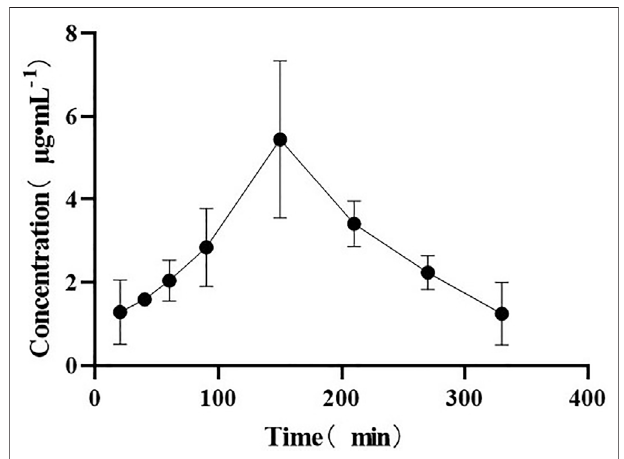
FIGURE 6 | Drug-time curve of